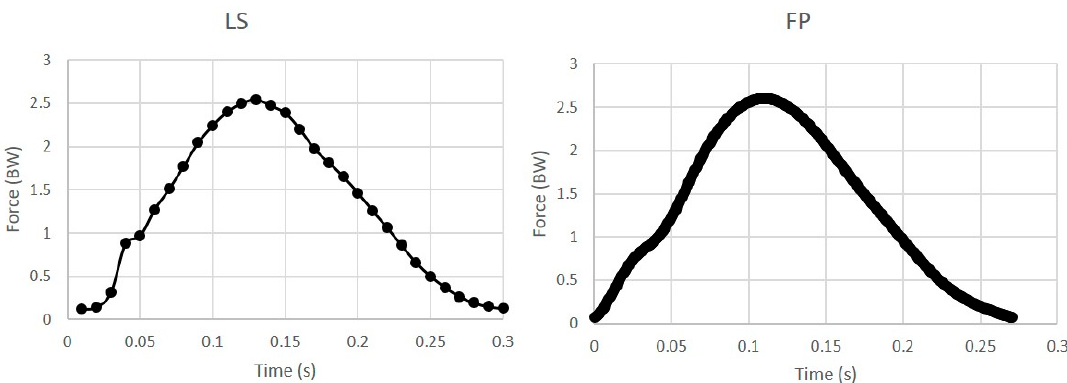
Figure 2. A representative image of the loadsol ® ( left ) and force plate ( right ) data for a single running step. Each dot represents one data point collected at 100 Hz for the loadsol ® and 1440 Hz for the force plate.